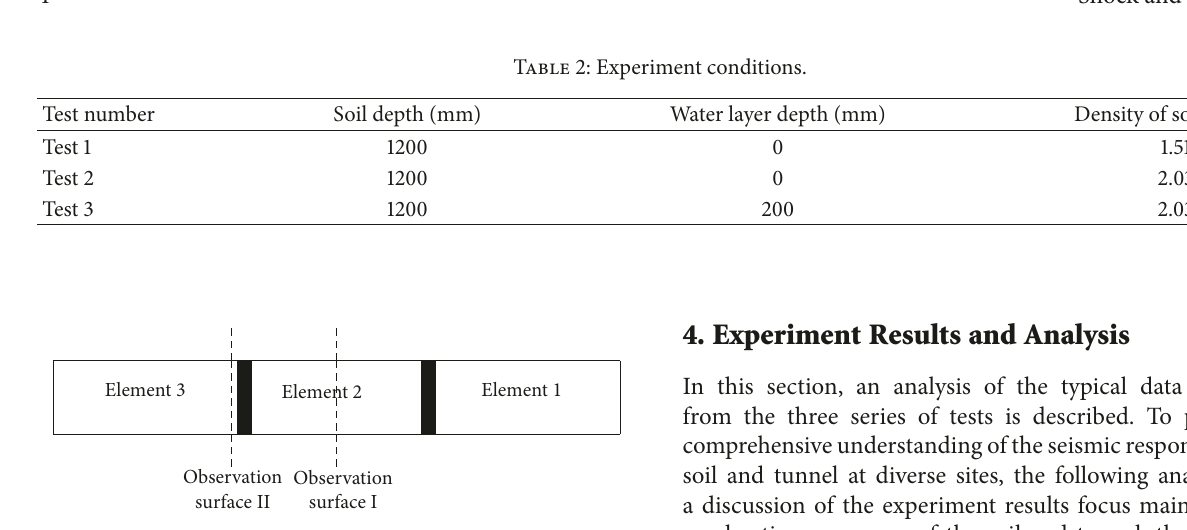
Figure 5: Plane view of observation